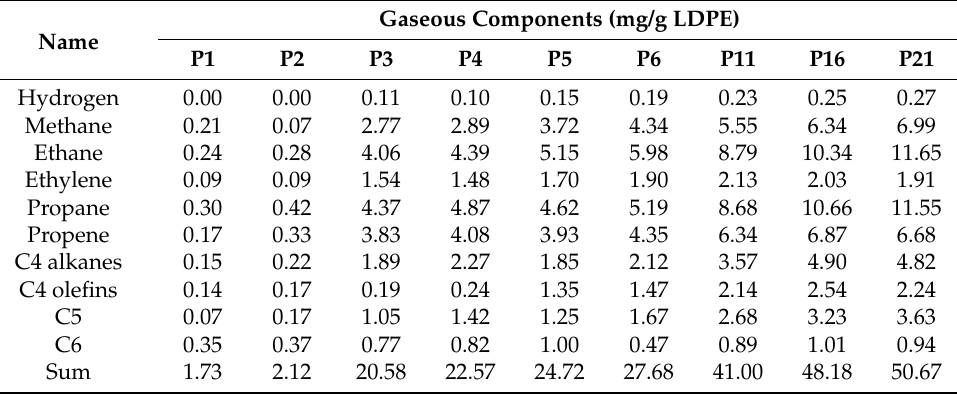
Figure 2. Pyrolysis experiments under different pressure conditions, in nitrogen atmosphere, at switch II and a set temperature of 380 ◦ C. ( A ) Peak temperatures from different pressure experiments. ( B ) Mn of the recovered oil or wax products from different pressure experiments. ( C ) Yields of the collected gas, liquid and wax fractions from different pressure experiments. ( D ) Oil product distribution from different pressure experiments; “others” refer to those components that are diffi- cult to accurately determine. Table 2. Chemical composition of gaseous products from different pressure experiments (listed in Table 1).